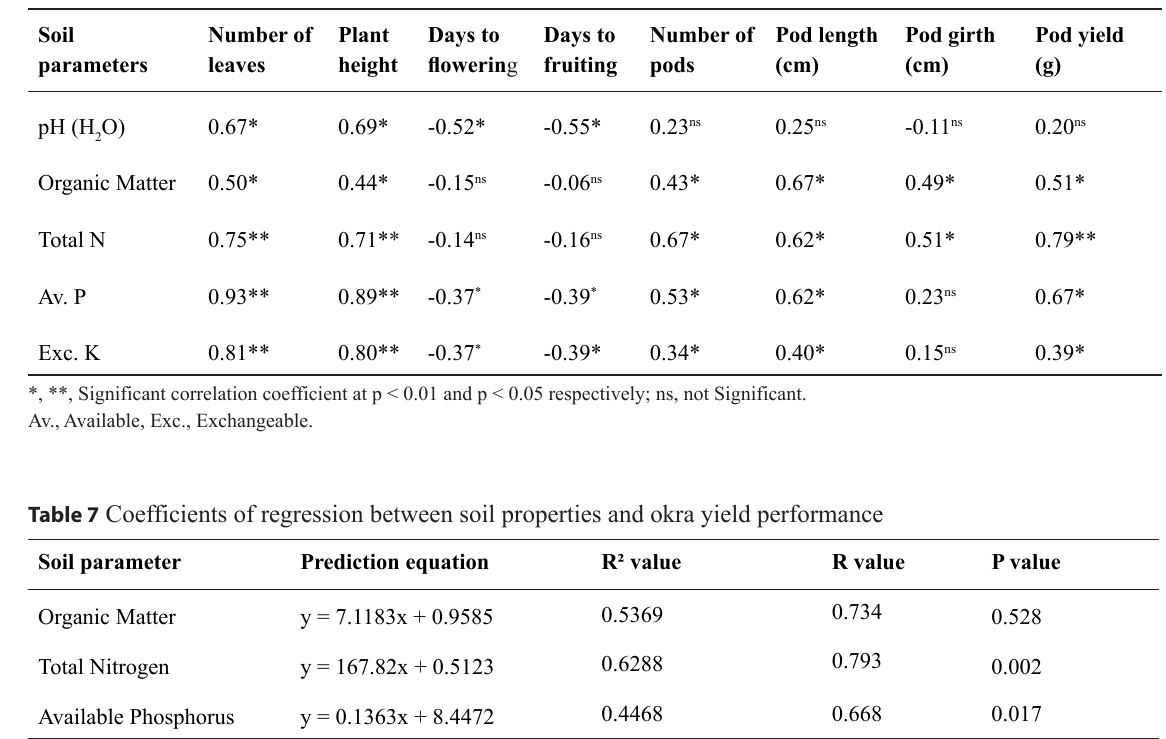
Available Phosphorus